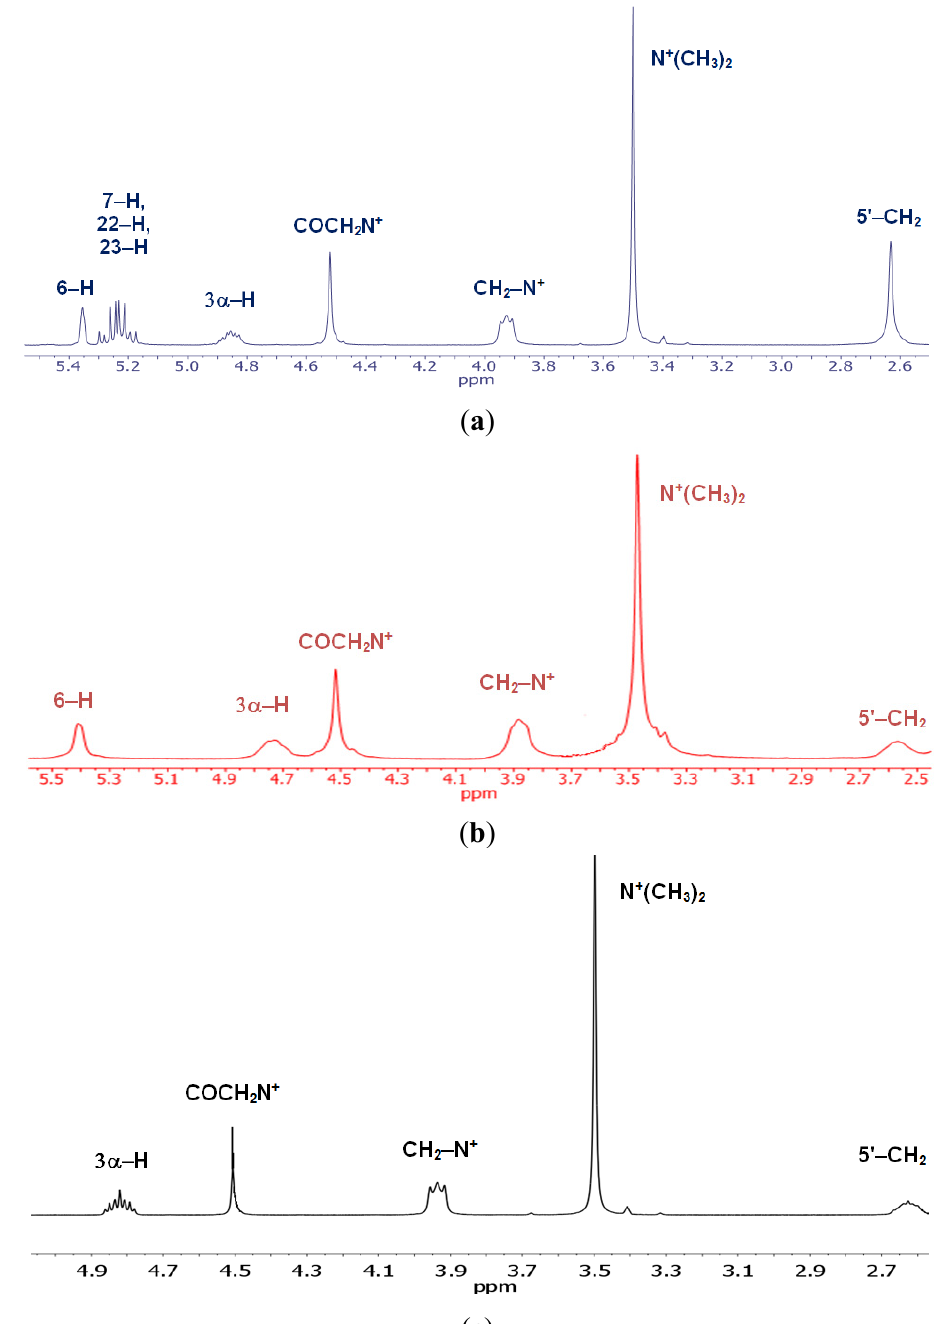
Figure 1. 1 H-NMR spectra in the 5.5–2.5 ppm region showing the most characteristic signals of conjugates 4 ( a ); 7 ( b ); and 10 ( c